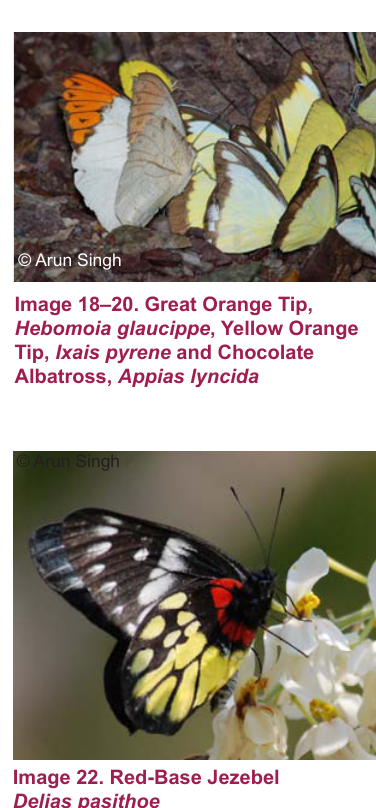
Image 15. Red Helen Papilio helenus